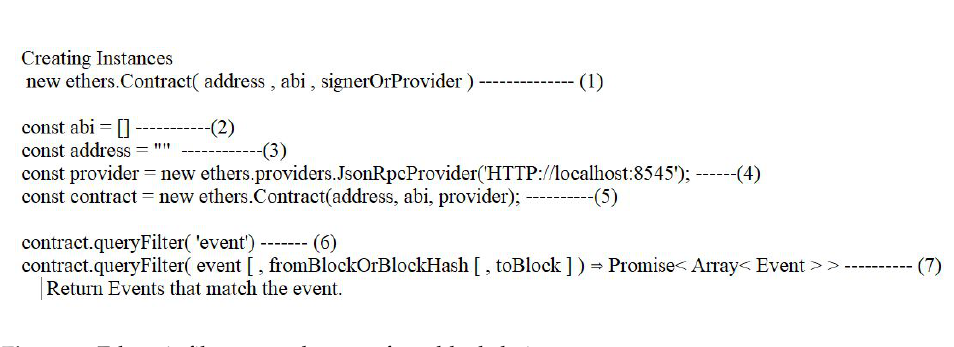
Figure 5. Ethers.js filter to read events from